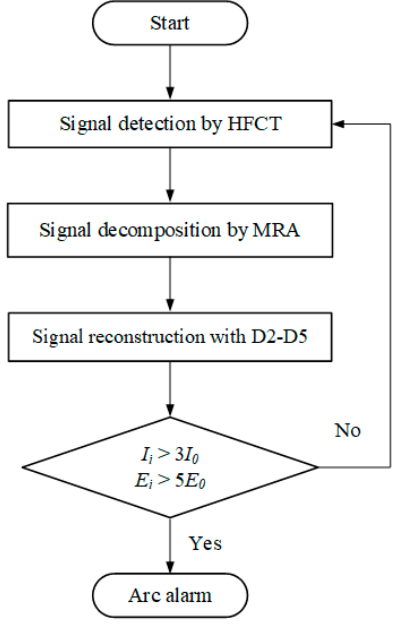
Figure 12. Flowchart of DC series arc identification.